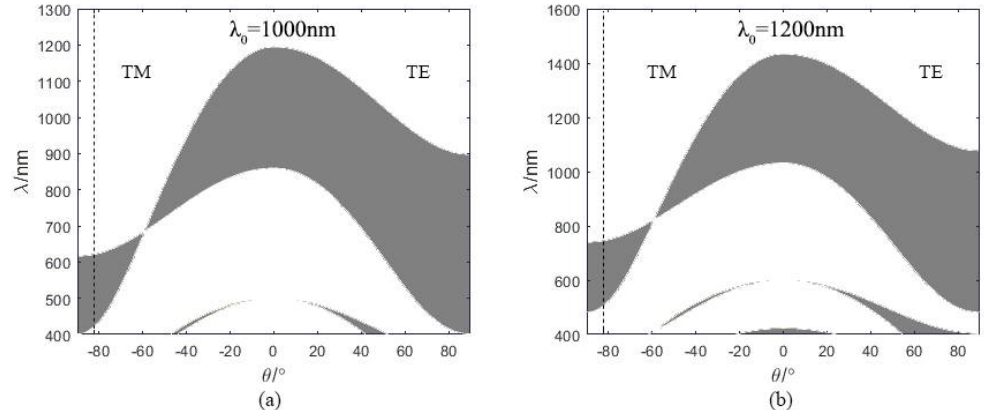
Figure 3. Band gap of 1 DPC with different center wavelength. The left side represents p-polarized light, while the right side represents s-polarized light. ( a ) λ 0 = 1000 nm, ( b ) λ 0 = 1200 nm.